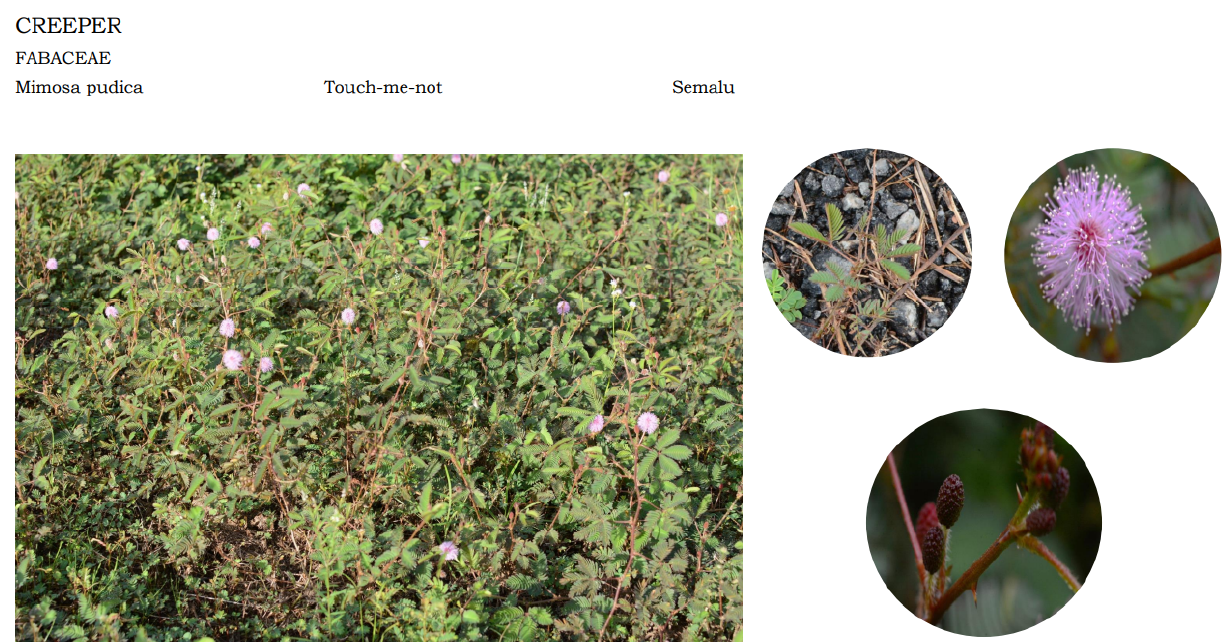
Figure A8. Herb Rubiaceae: Oldenlandia corymbosa.